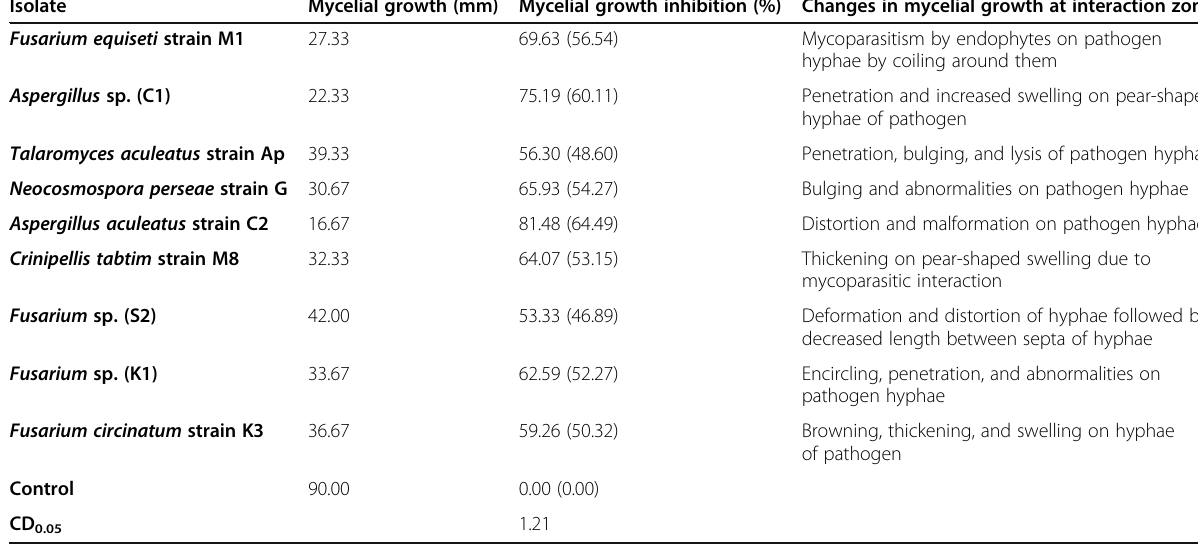
Figures in parentheses are arc sine transformed